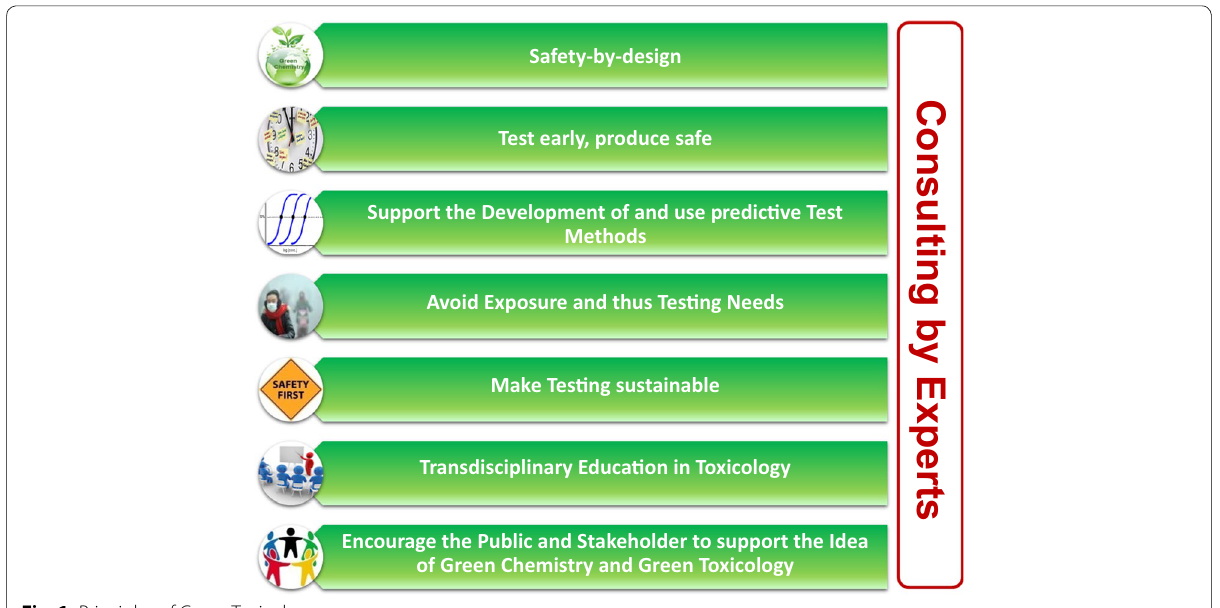
Fig. 1 Principles of Green